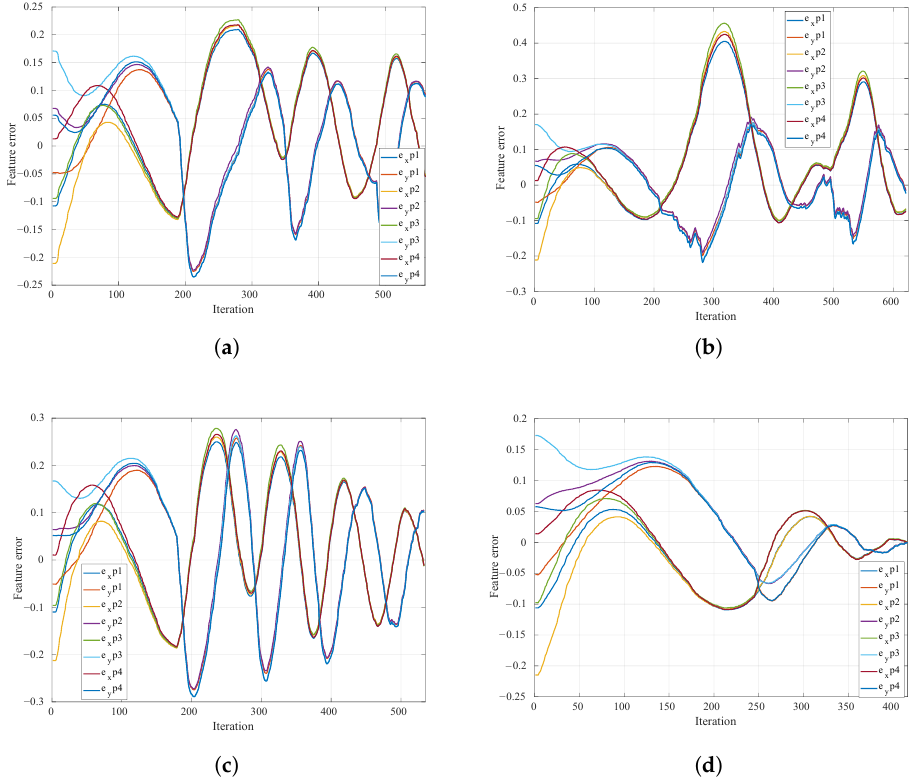
Figure 5. Performance analysis of four different VS methods in completing a similar task in presence of singularity. ( a ) Failure in completing the VS task with PBVS approach. ( b ) Failure in completing the VS task with IBVS approach. ( c ) Failure in completing the VS task with HVS approach. ( d ) Success in completing the VS task with DHVS